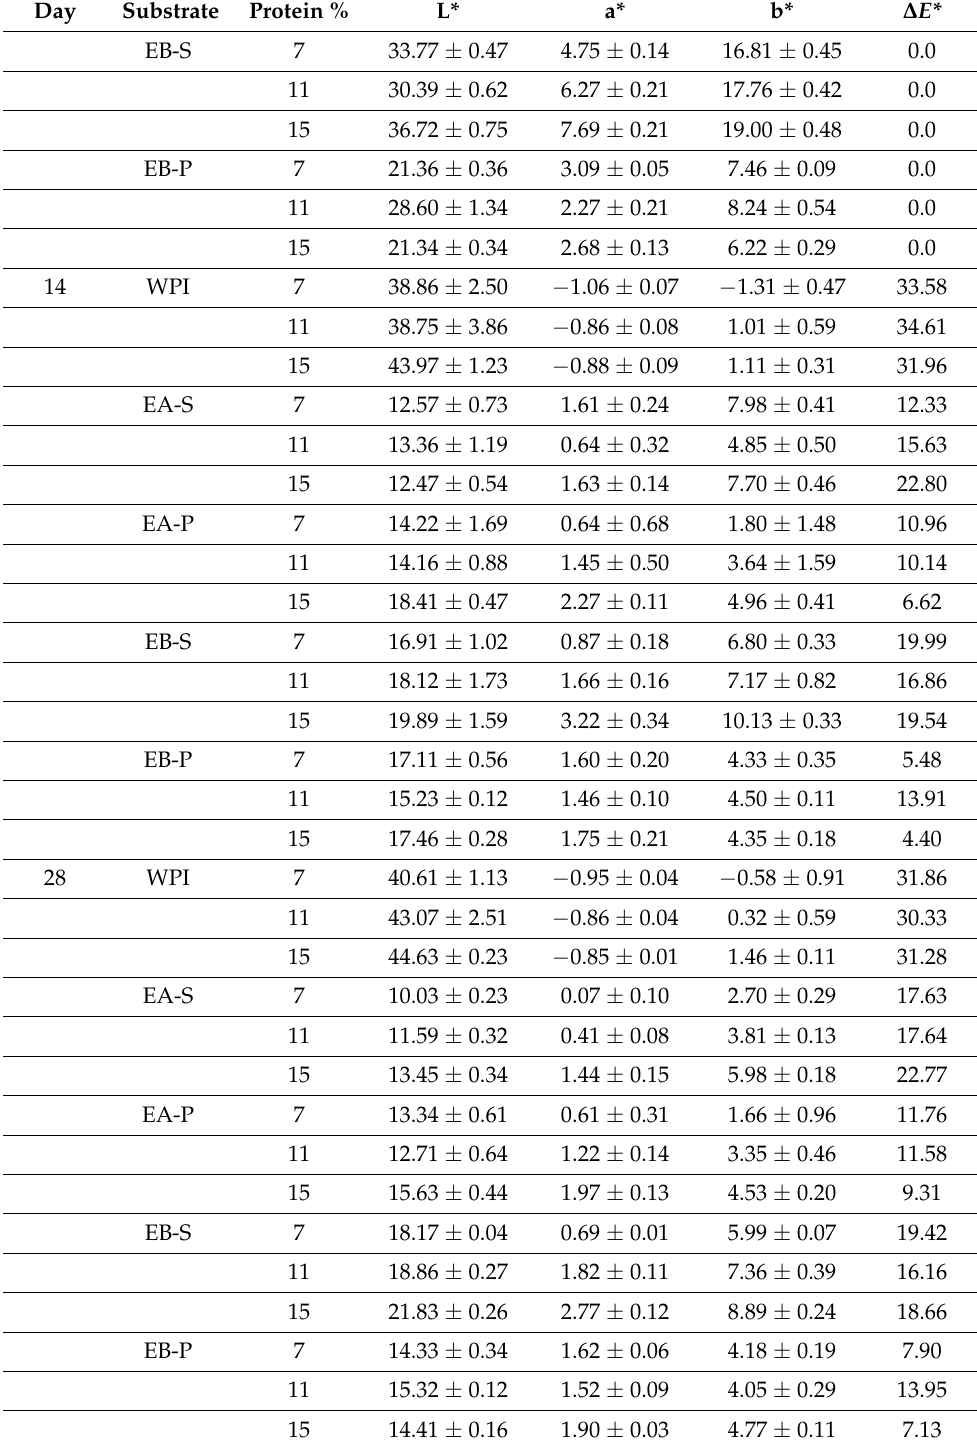
The position between red and green (a*negative values indicate green while positive values indicate red), for the gel with WPI varied between − 2.73 and − 1.43 depending on the WPI concentration; and its position between yellow and blue (b*negative values indicate blue and positive values indicate yellow), varied between − 1.81 and 4.24, depending on the WPI concentration. With respect to gels containing insect protein, all the values of